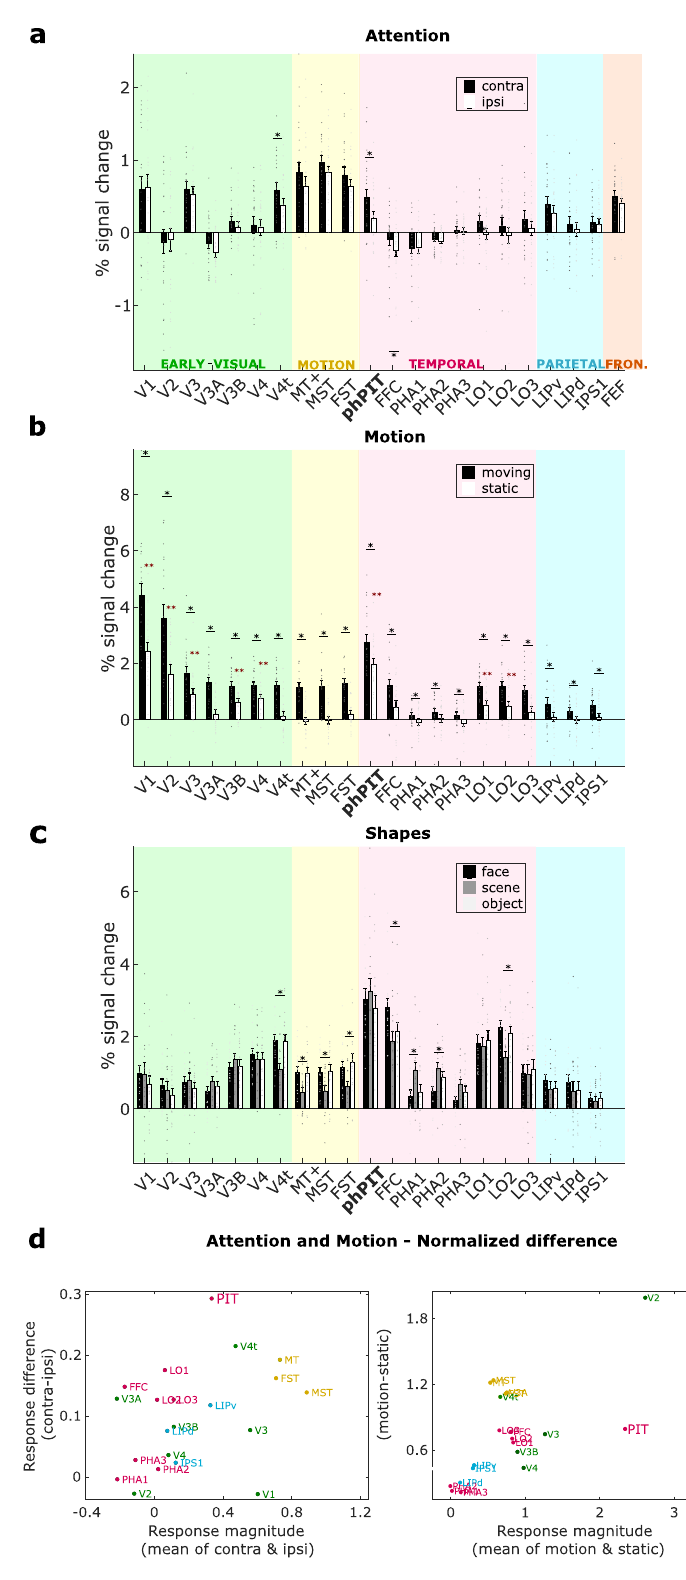
TP – SPL are noted to exhibit a predominantly vertical orientation, but again have an anterior – posterior elongation different from phPIT – LIP tract and their ventral endpoints are located anteriorly to phPIT (Fig. 6a; yellow vs. red and green streamlines; see also Fig. S6). To estimate and compare the similarity between attentional tracts and the previously characterized major